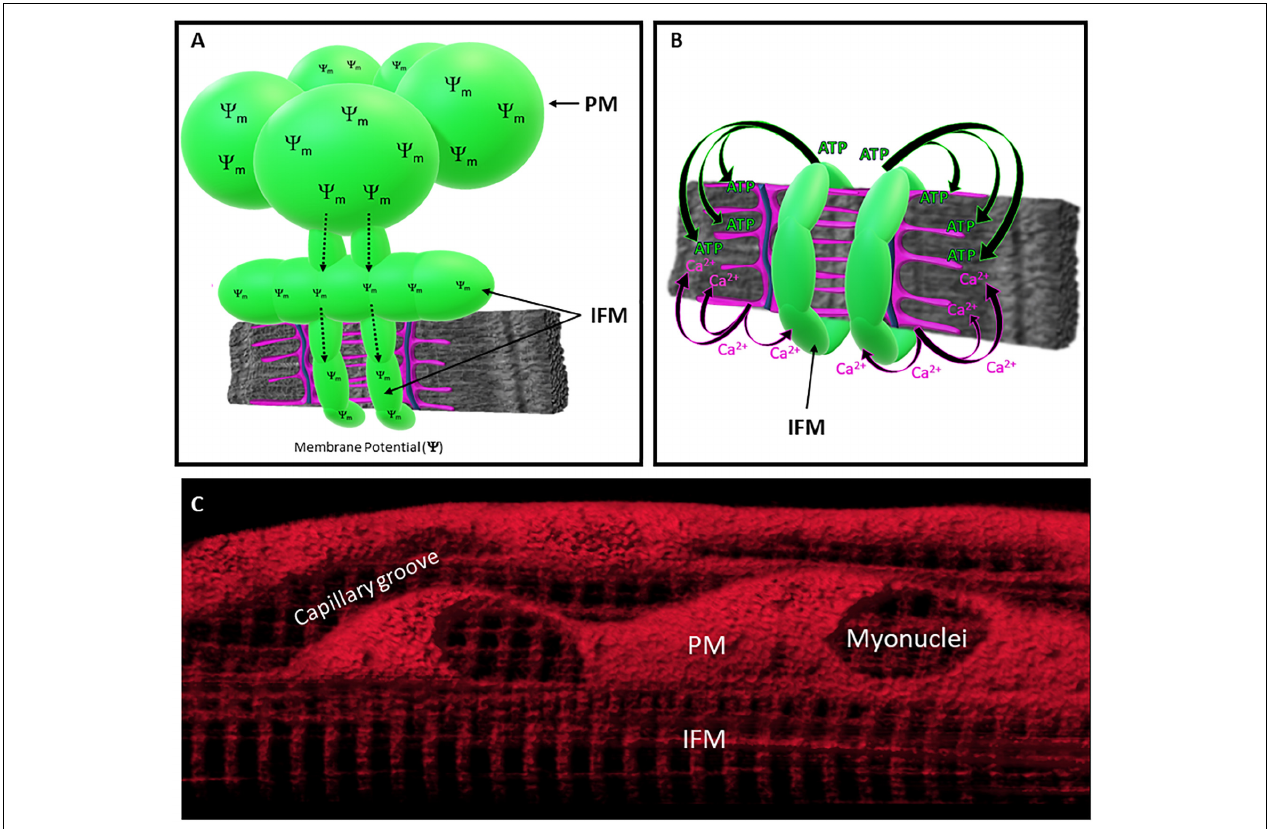
FIGURE 2 | Specialization of Mitochondrial Function across Subcellular Regions. (A) Membrane potential generated in PM can be distributed throughout the IFM network through mitochondrial connectivity. (B) IFM directly supports myofibrillar contraction by generating ATP. Coordination between myofibrillar contraction and IFM energy conversion are mediated by Ca 2 + release from the sarcoplasmic reticulum (SR). Mitochondria (green), SR (magenta), t -tubule (blue), and myofibril (gray). (C) Mitochondrial membrane potential distributed throughout the mitochondrial network of living skeletal muscle